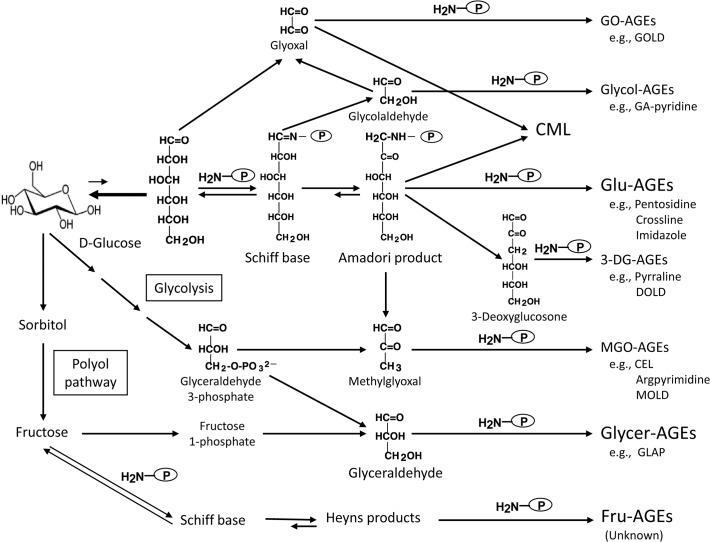
Alternative in vivo AGE synthesis routes.Reducing sugars, such as glucose, fructose, and glyceraldehyde, are known to react non-enzymatically with the amino groups of proteins to form reversible Schiff bases and Amadori/Heyns products. These early glycation products undergo further complex reactions such as rearrangement, dehydration, and condensation to become irreversibly cross-linked heterogeneous fluorescent derivatives, termed AGEs. Glu-AGEs, glucose-derived AGEs; Fru-AGEs, fructose-derived AGEs; Glycer-AGEs, glyceraldehyde-derived AGEs; Glycol-AGEs, glycolaldehyde-derived AGEs; MGO-AGEs, methylglyoxal-derived AGEs; GO-AGEs, glyoxal-derived AGEs; 3-DG-AGEs, 3-deoxyglucosone-derived AGEs; CML, N
ε-(carboxymethyl)lysine; P-NH2, free amino residue of protein; GOLD, GO-lysine dimer; GA-pyridine, 3-hydroxy-4-hydroxymethyl-1-(5-carboxypentyl) pyridinium cation; DOLD, 3-DG-lysine dimer; CEL, N
ε-(carboxyethyl)lysine; MOLD, MGO-lysine dimer; GLAP, glyceraldehyde-derived pyridinium compound.